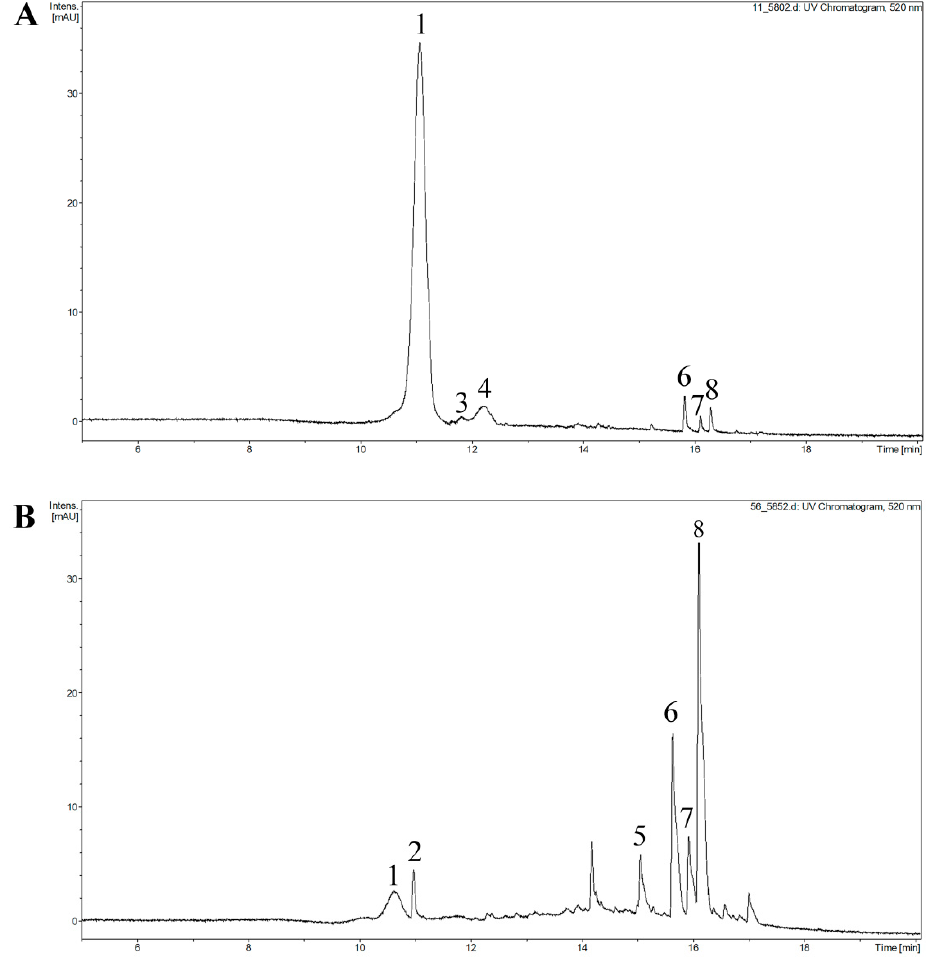
Figure 5. The UPLC chromatograms of BFSA group cherry wine in 520 nm (eight anthocyanins were detected in BFSA group), aging for 0 days ( A ); aging for one year ( B ). Peak 1, cyanidin-3-rutinoside; peak 2, 10-carboxy-pyranocyanidin-3- O -rutinoside; peak 3, 10 H -pyranocyanidin-3- O -rutinoside; peak 4, peonidin-3-rutinoside; peak 5, 10-catechypyranocyanidin-3- O -rutinoside; peak 6, 10-hydroxyphenyl-pyranocyanidin-3- O -rutinoside; peak 7, 10-guaiacyl-pyranocyanidin-3- O -rutinoside; peak 8, 10-syringyl-pyranocyanidin-3-rutinoside.